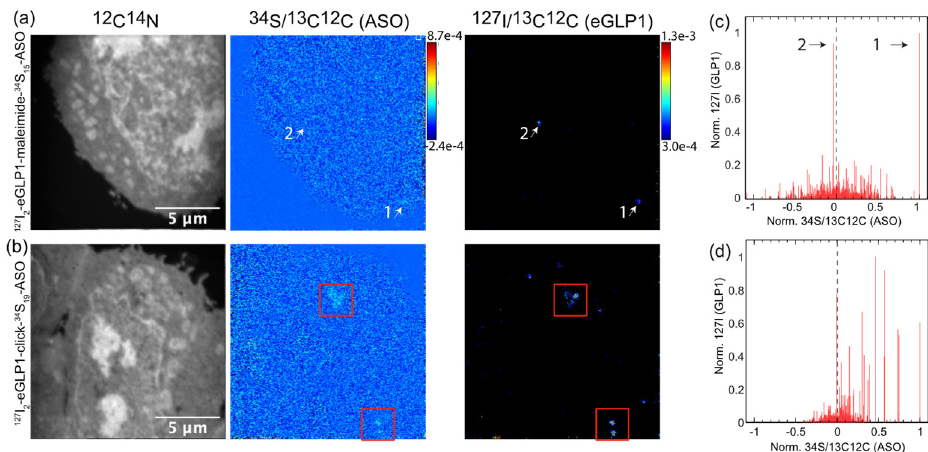
Figure 10. The 127 I 2 -eGLP1- 34 S 19 -ASO click. ( a ) NanoSIMS images of GLP1R-HEK293 cells incubated for 30 min with 127 I 2 -eGLP1- 34 S 15 -ASO maleimide: 12 C 14 N, 34 S/ 13 C 12 C (ASO), 127 I/ 13 C 12 C (eGLP1). ( b ) NanoSIMS images of GLP1R-HEK293 cells incubated with 127 I 2 -eGLP1- 34 S 19 -ASO click: 12 C 14 N, 34 S/ 13 C 12 C (ASO), 127 I/ 13 C 12 C(GLP1). White arrows indicate spots 1 and 2 as described in the text. Red boxes indicate spots of 34 S/ 13 C 12 C (ASO), which were observed together with spots of 127 I/ 13 C 12 C (eGLP1). ( c ) ROI analysis of 127 I 2 -eGLP1- 34 S 15 -ASO maleimide-treated GLP1R-HEK293 cells with signal corresponding to spots 1 and 2 indicated by black arrows. ( d ) ROI analysis of 127 I 2 -eGLP1- 34 S 19 -ASO click-treated GLP1R-HEK293 cells.